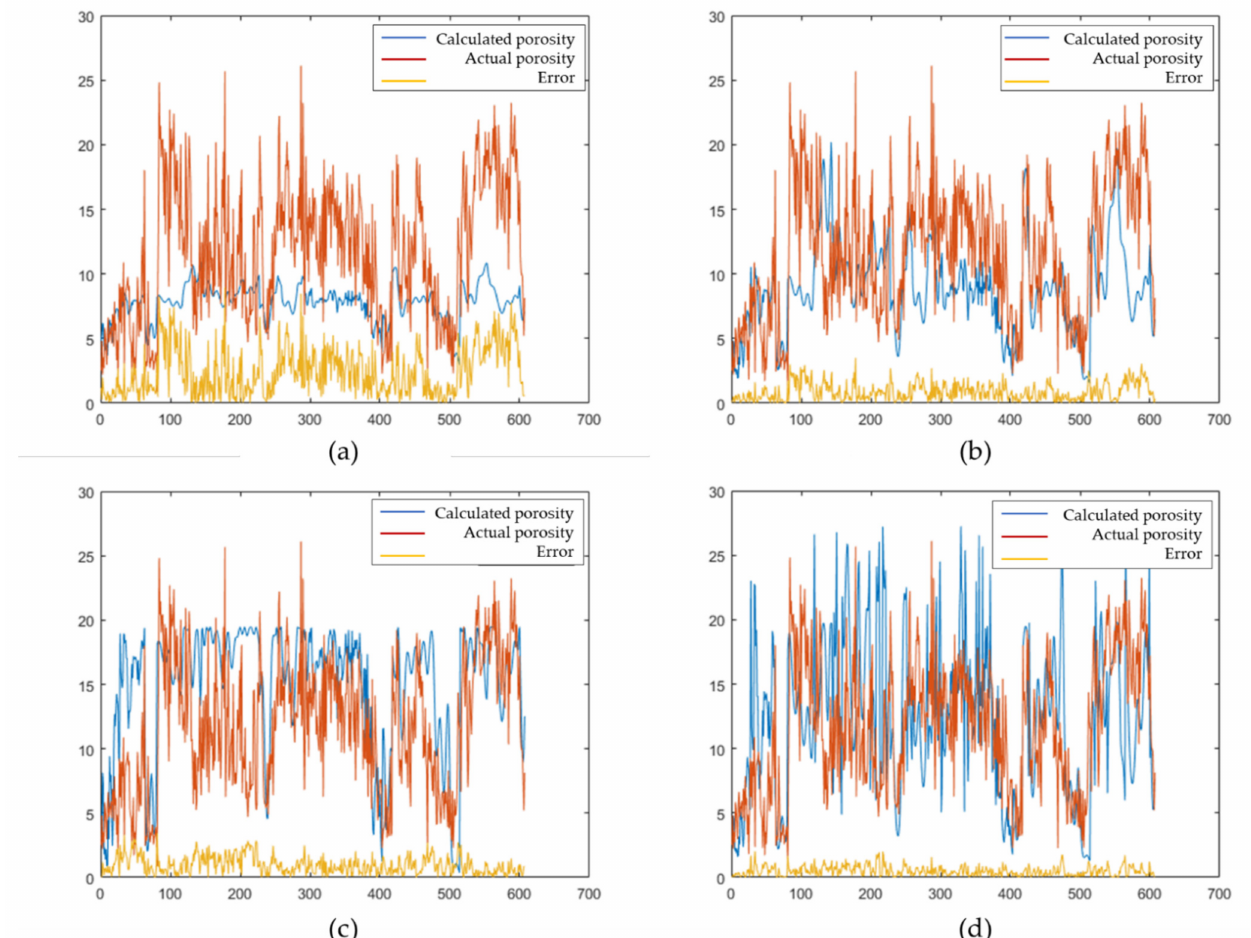
Figure 14. Four typical examples encountered in the hyperparameter selection process. There are different learning rates between ( a , b ), different numbers of hidden units between ( b , c ), and different dropout factor functions between ( b , d